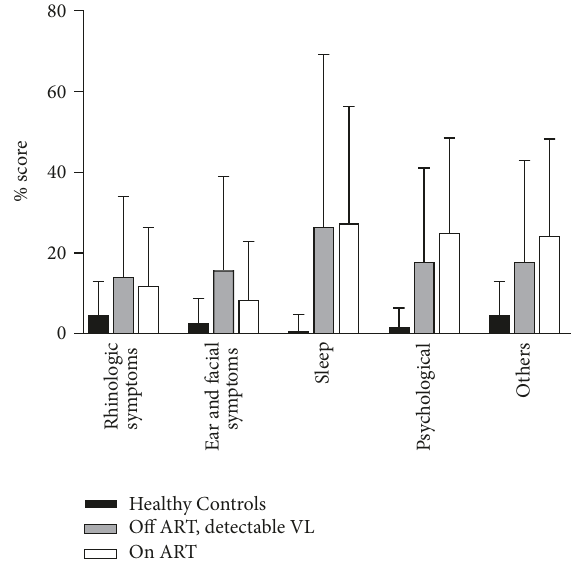
Figure 2: SNOT-20 questionnaire scores across the 3 groups of par- ticipants . Participants with HIV infection both on and off ART had higher total scores on the questionnaire ( 𝑝 = 0.013 ). This difference was observed in all domains, although higher scores among HIV groups were driven by sleep and psychological symptoms more than rhinologic or ear and facial